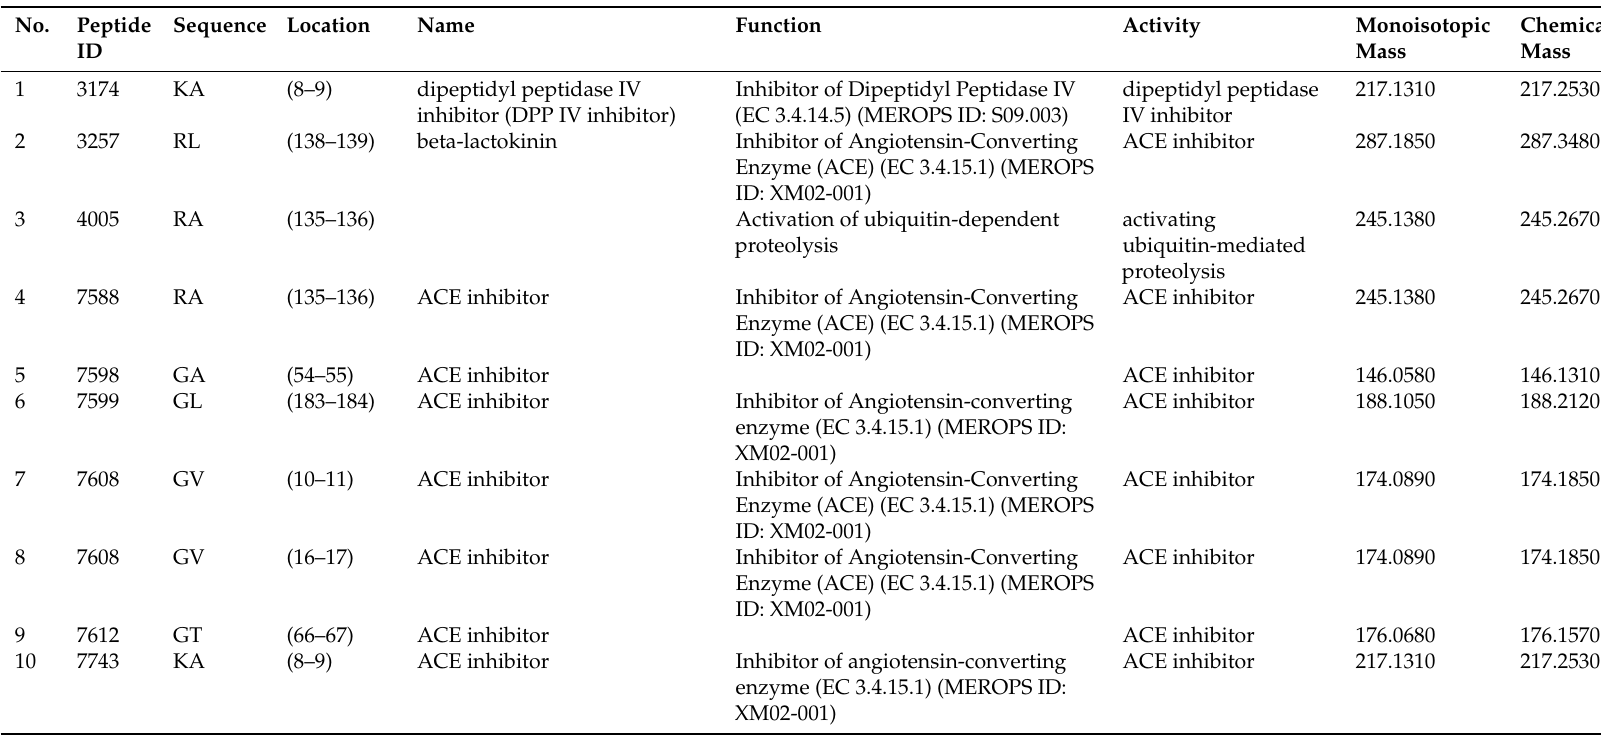
Table A31. Bioactive peptides from RubisCO of Halophila stipulacea . In silico enzymatic cleavage was carried out by using leukocyte